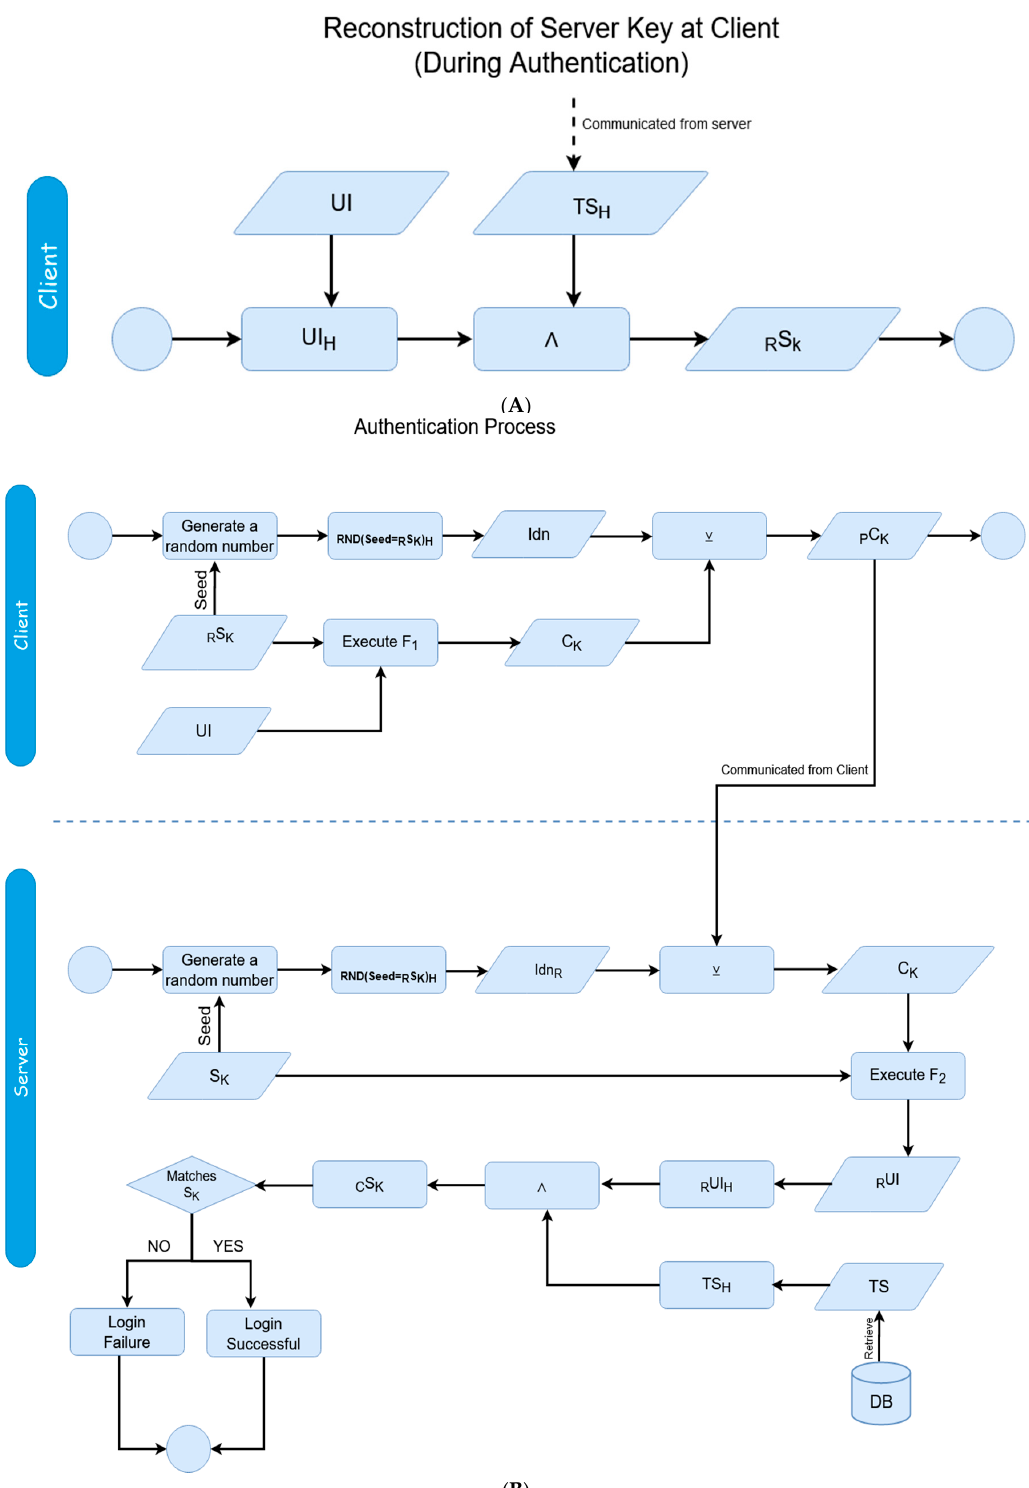
Figure 3. ( A ) User verification process—reconstruction of server key; ( B ) User verification process.